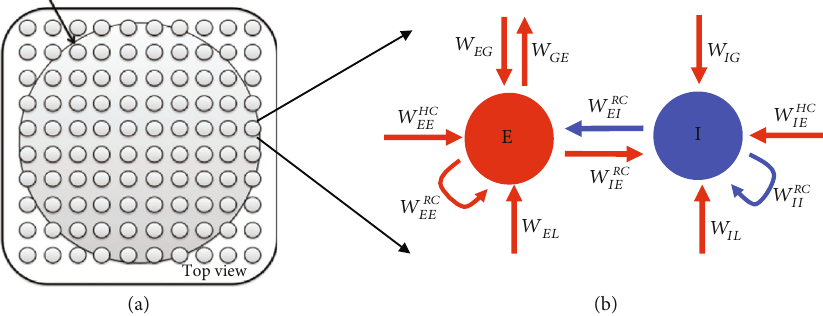
Figure 1: The network architecture of a large scale network model. Small grey circular patches in (a) represent 15 by 15 local components in the network. These local components are placed horizontally on a plane parallel to cortical surface which mimic hypercolumns in V1. The spatial range of activation zone, or the number of activated E-I units in the model, is dependent on the size of external visual stimulus. Each local component in (b) consists of excitatory (E) and inhibitory (I) component connected with local connection W RC EE , W RC EI , W RC IE , and W RC II . In the cortical space, the E and I components receive feedforward input ( W EL , W IL ) from subcortical regions (LGN) that are driven by visual stimuli, horizontal inputs ( W HC EE and W HC IE ) from other E-I units and receives feedback ( W EG , W IG ) from higher visual cortex (G). The higher visual cortex (G) receives feedforward ( W GE ) input from V1 as